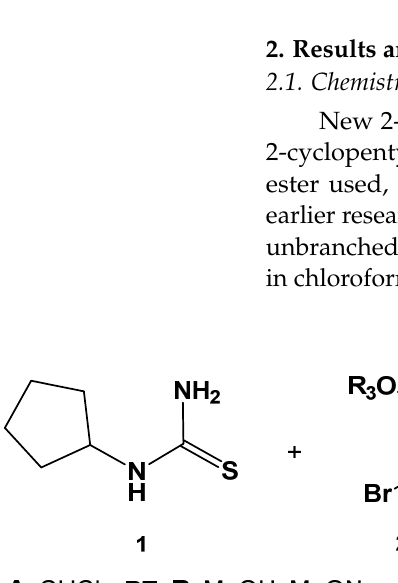
Figure 2. Synthesis of 2-(cyclopentylamino)thiazol-4(5 H )-one.